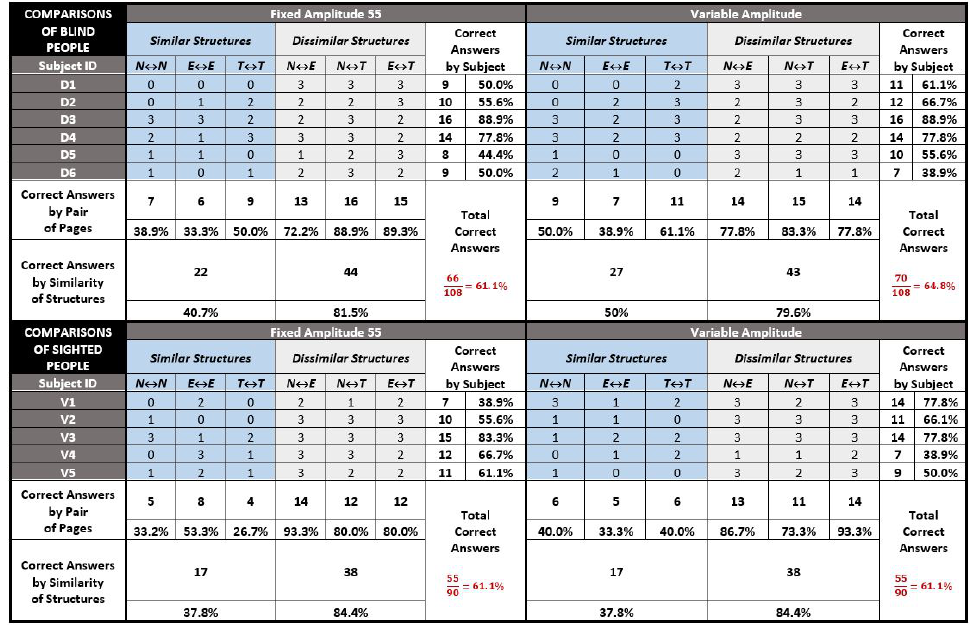
Figure 9. Results of all